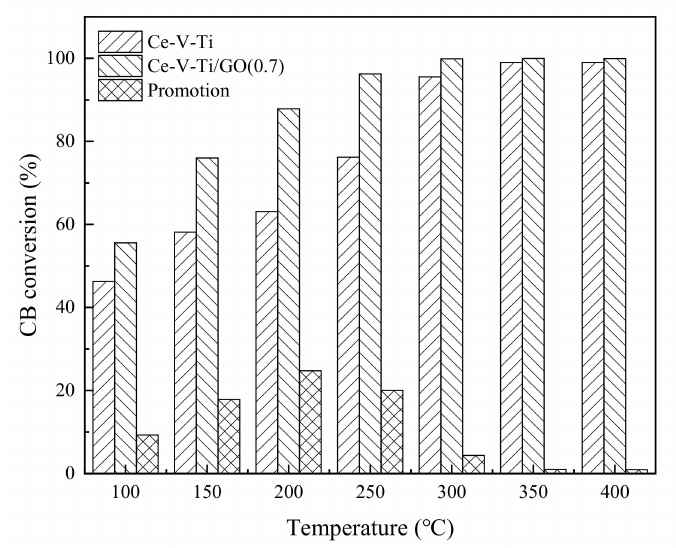
Figure 2. CB conversion over Ce-V-Ti and Ce-V-Ti / GO catalysts; CB: 100 ppm; gas hour space velocity (GHSV): 30,000 h − 1 ; catalyst amount: 200 mg.